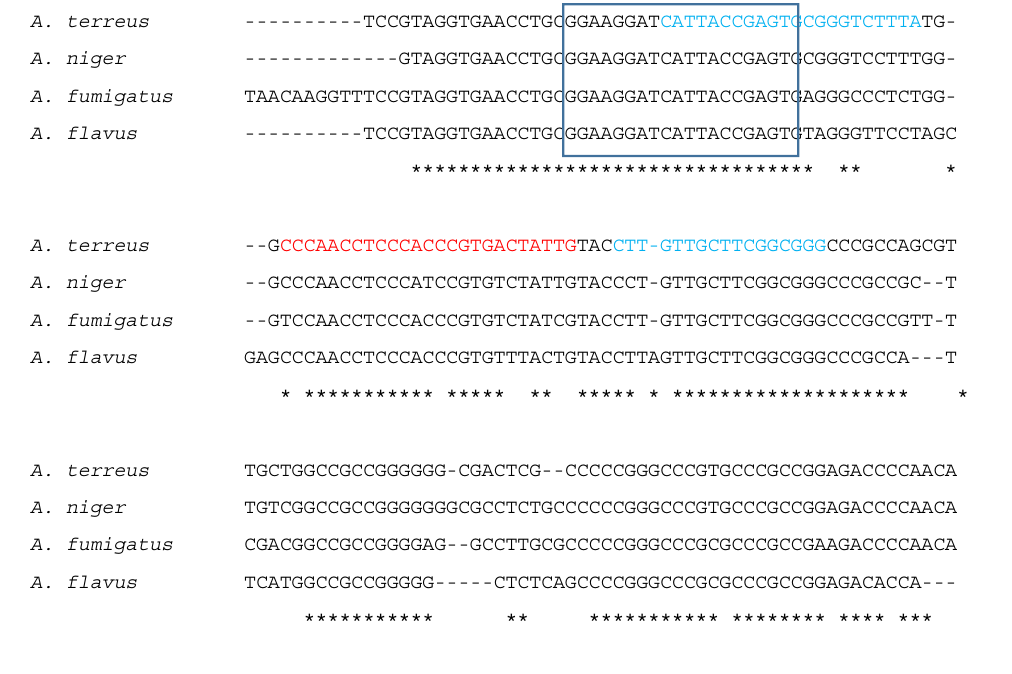
Alignment of four clinically important Aspergillus species. TaqMan primers (blue) and probes (red) are shown by their respective coloration. Pan- Aspergillus primers are indicated by boxes.